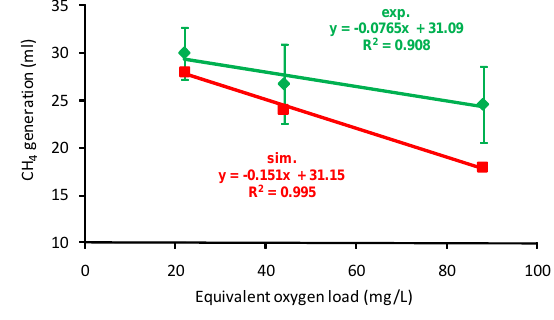
Figure 5: Analysis of linearity for experimental and simulated data in the 22 – 88 mg/L oxygen load